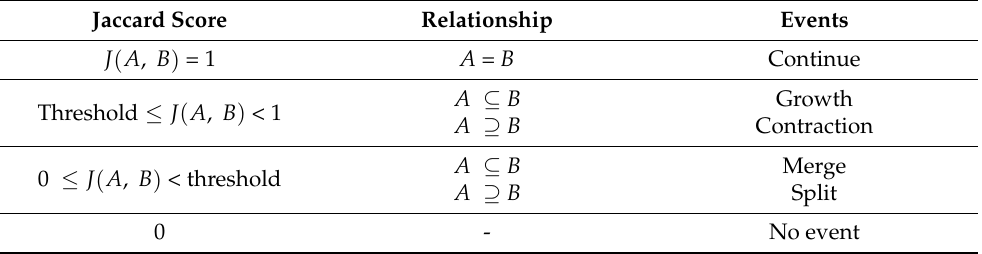
Table 2. Event definition table. A is the urban community of the month before and B is the urban community of the month